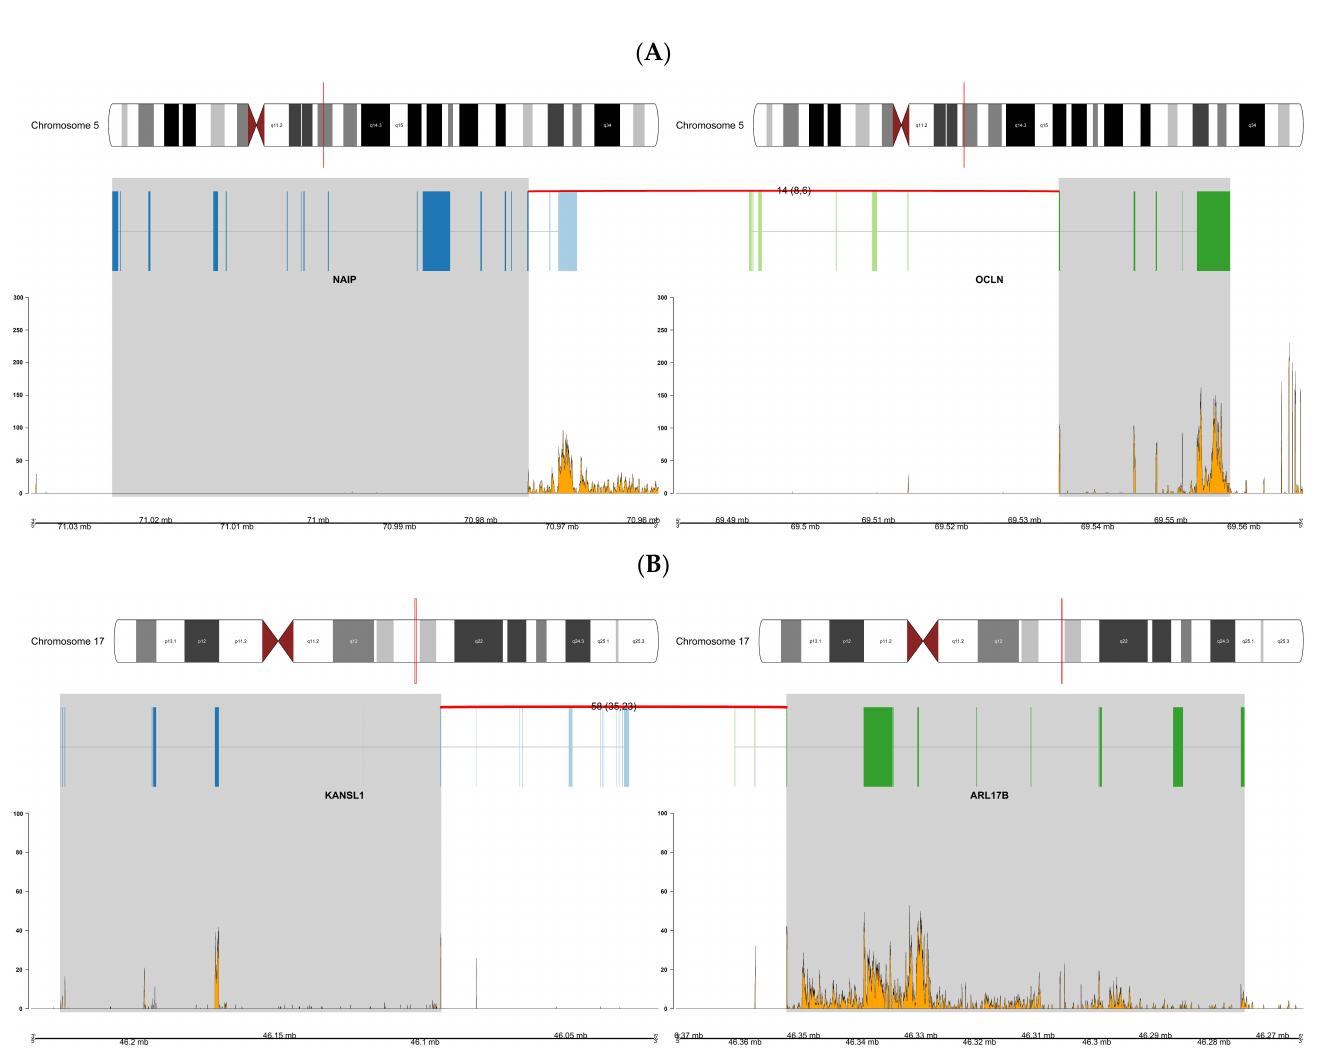
Figure 6. ( A ) Overview of the NAIP:OCLN fusion gene found in patient AA 20. The plot displays the locations on chromosome 5 of the fusion partner genes. ( B ) Overview of fusion KANSL1:ARL17B for patient EA 5. The plot displays the locations on chromosome 17 of the fusion partner genes. The plots display the locations on chromosome 5 and 17, respectively, of the fusion partner genes, the number of discordant (split and spanning, respectively, in parentheses) reads supporting the breakpoint indicated by the red line between partner genes, transcript information showing the exons in each partner gene, and, lastly, the RNA expression of partner genes beside their genomic location in Mb.